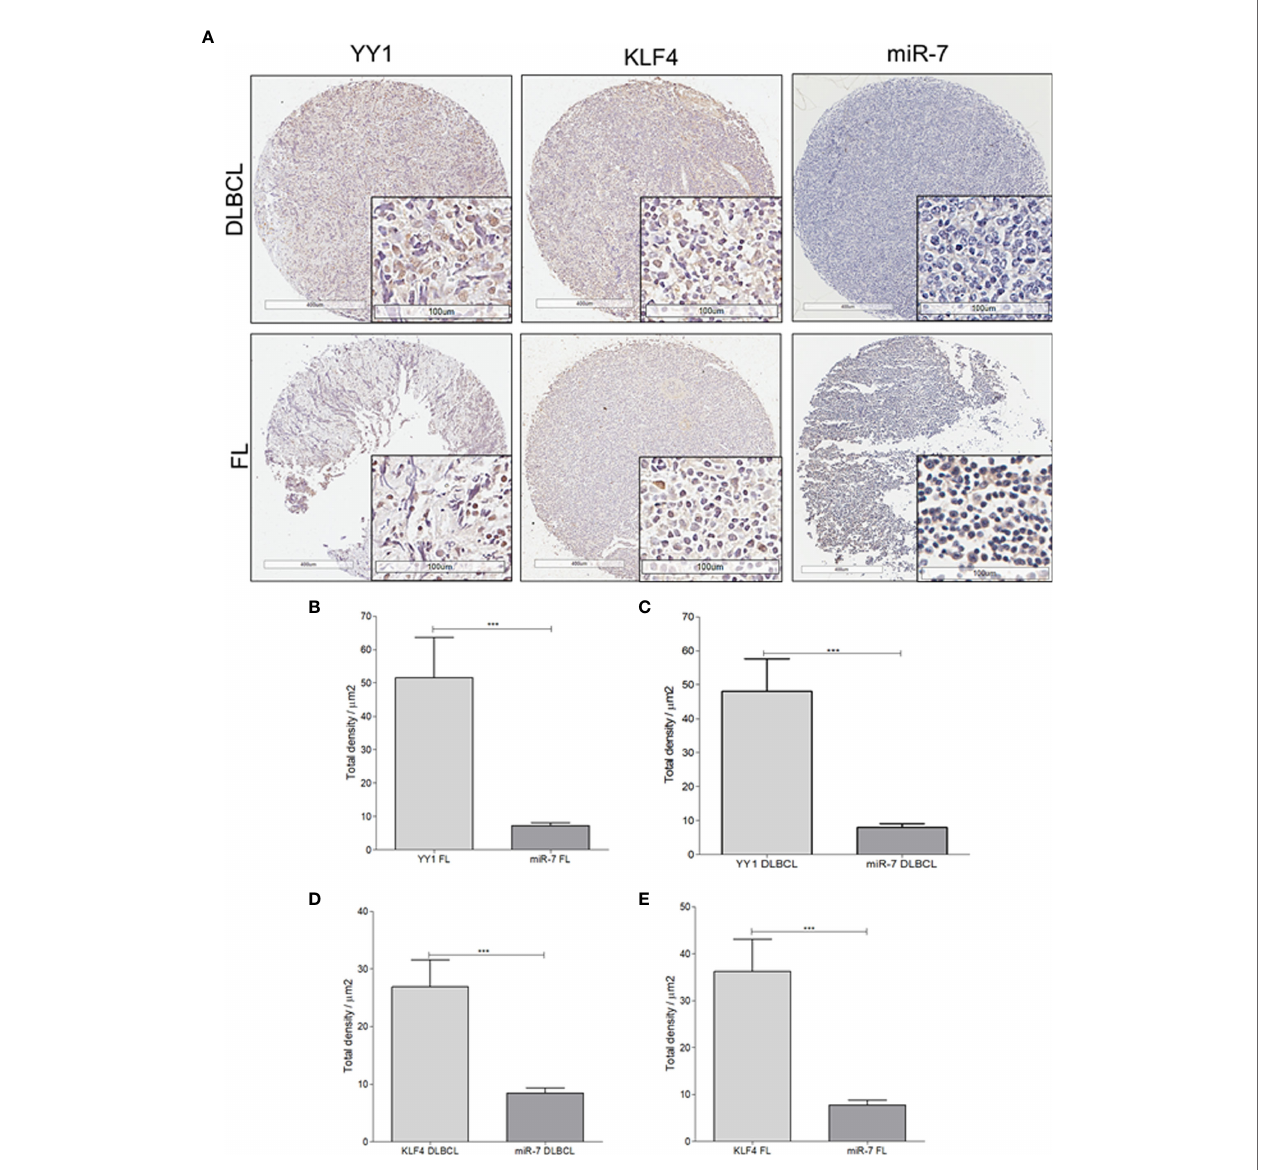
FIGURE 4 | Expression of miR-7, KLF4, and YY1 in NHL tissues. (A) Representative micrographs of KLF4 and YY1 expression analyzed by immunohistochemistry, and miR-7 expression evaluated by in situ hybridization in a tissue microarray of patients with NHL are shown. (Top) different markers in biopsies of DLBCL. (Below) representative micrograph of different markers in follicular lymphoma biopsies (original magni fi cation: 4X and 40X in the frame. (B – E) Density expression of miR-7, YY1, and KLF4 were reported and total expressions for each subtype were compared (*** p <